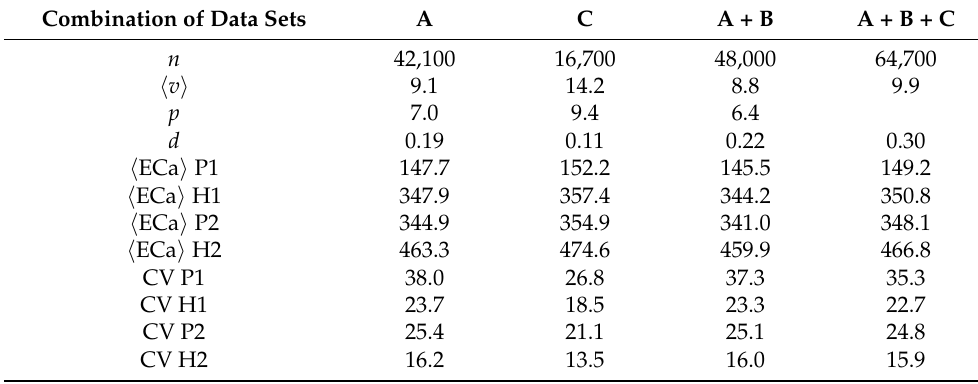
Table 1. Characteristics of the different combined ECa data sets and descriptive statistics for the different EMI signals. The total number of measurements ( n ), average speed ( (cid:104) v (cid:105) , km/h), the average spacing between measurement lines ( p , m), spatial data density ( d , points/m 2 ) and average ECa ( (cid:104) ECa (cid:105) , mS/m), and coefficient of variation (CV, %). Combination of Data